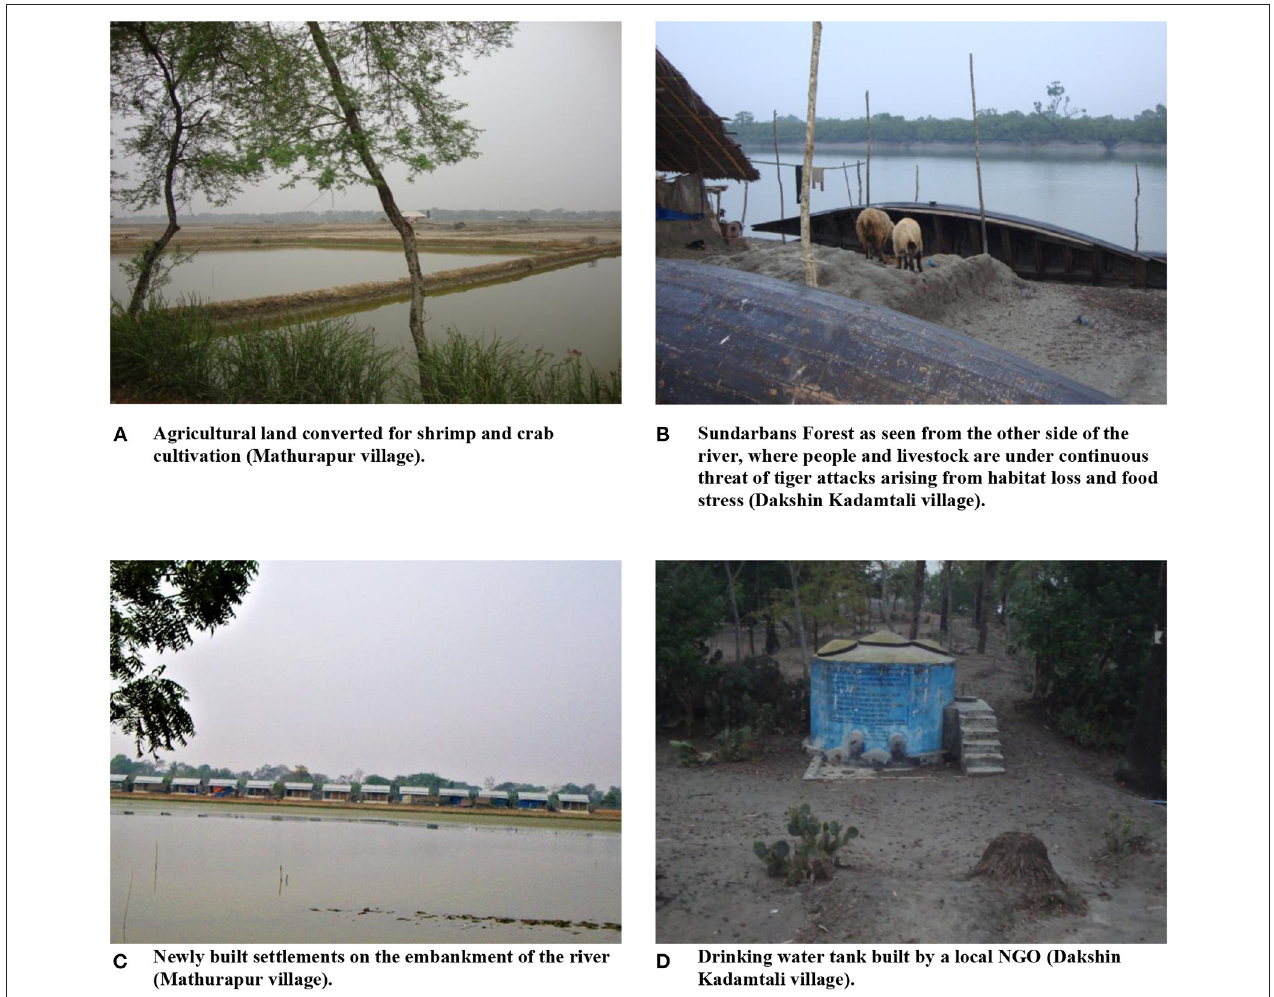
FIGURE 6 | (A–D) Local policy beneficiary level: Munshigang Union, Shyamnagar Sub-District of Satkhira District, January 2012 (Photographs by